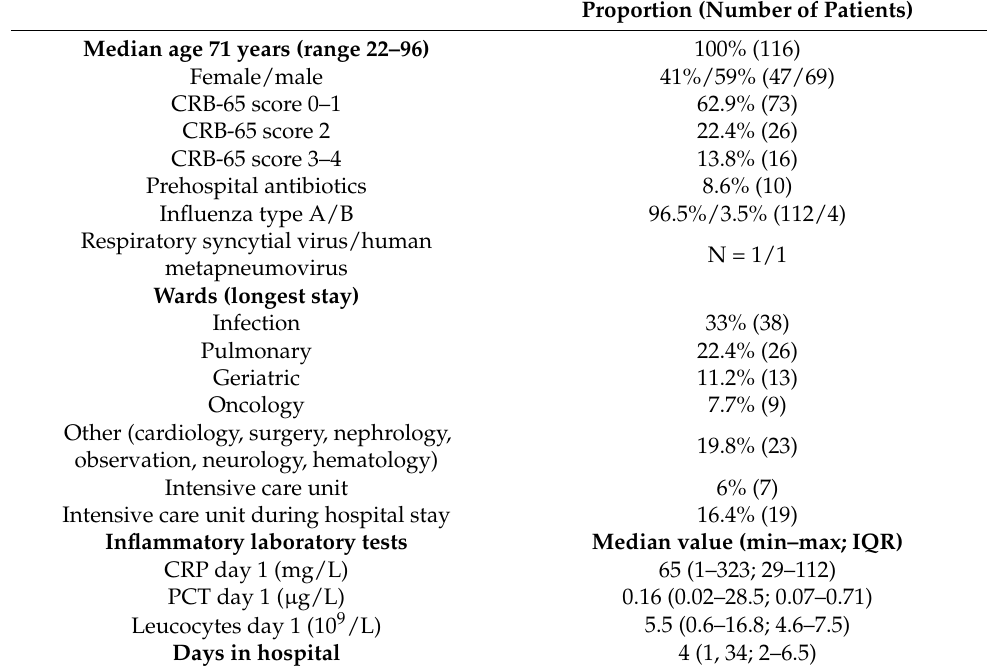
Table 1. Patient characteristics in hospital.